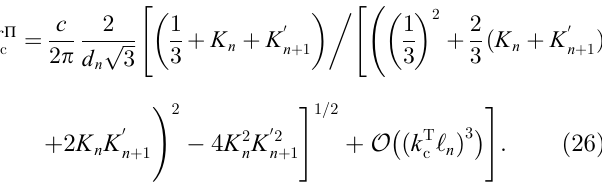
Figure 5. The input impedance (modulus and argument) and re fl ection coef fi cient (modulus and argument), measured for the G ] fi ngering (written pitch, 246 Hz) of an alto saxophone. The cutoff transition band f R